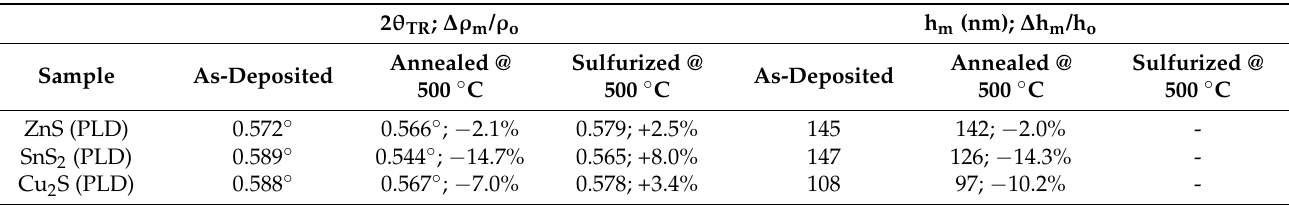
Table 1. Position of the total reflection edge (2 θ TR ) and the average thickness (h m ) (as well as their relative variation) of the as-deposited, annealed, and sulfurized CZTS thin